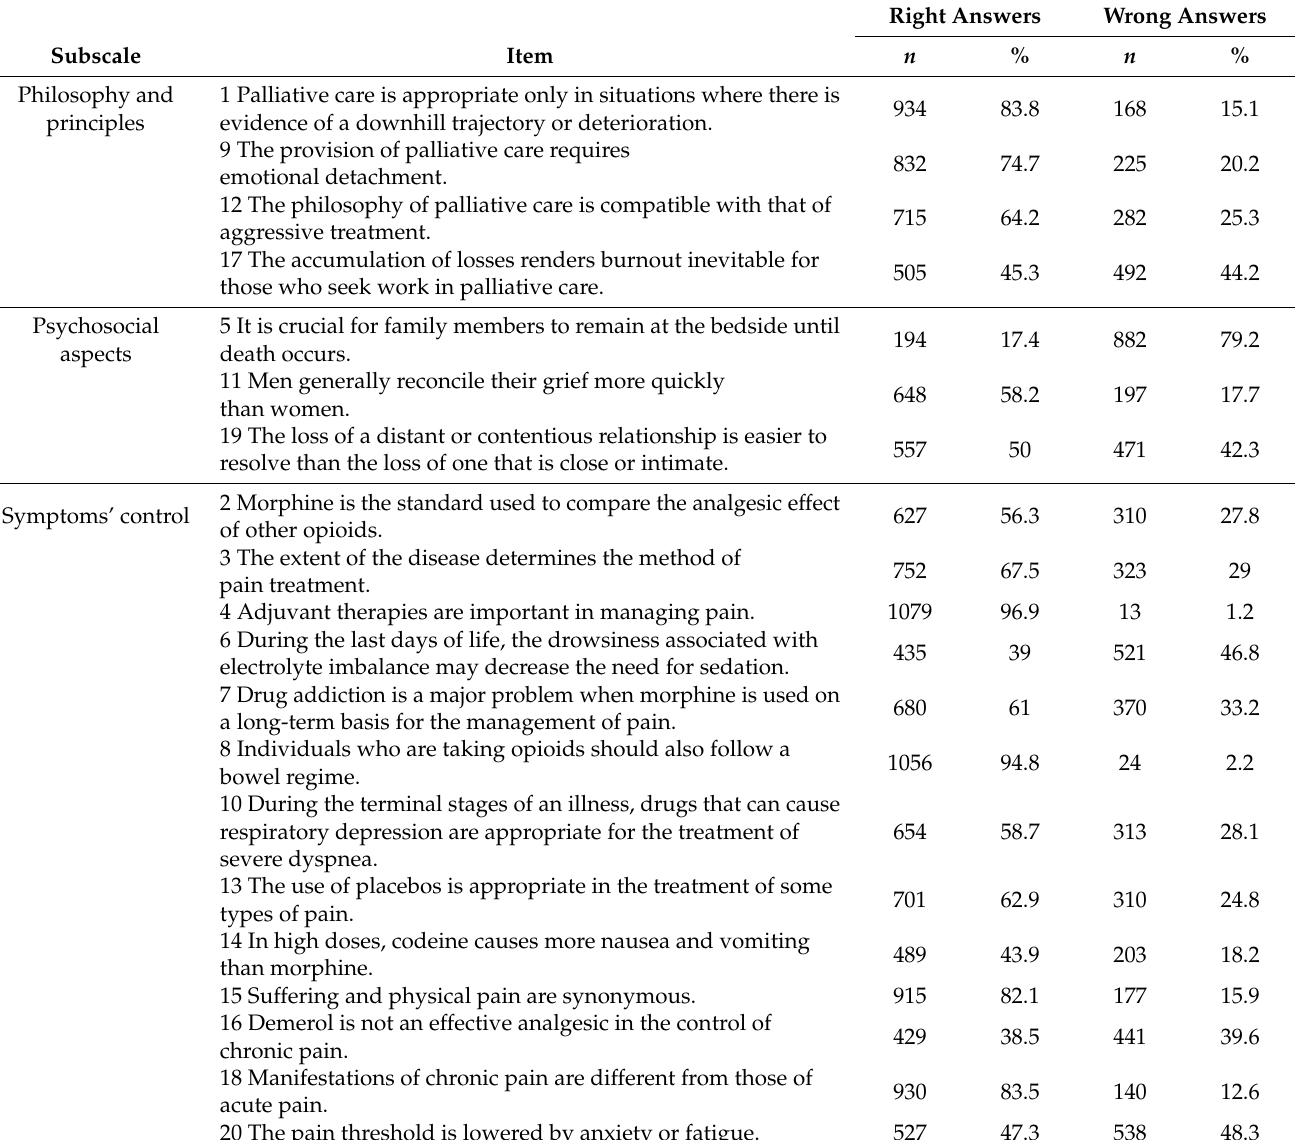
Table 2. Right and wrong answers for each question composing the PCQN-SV and its subscales.